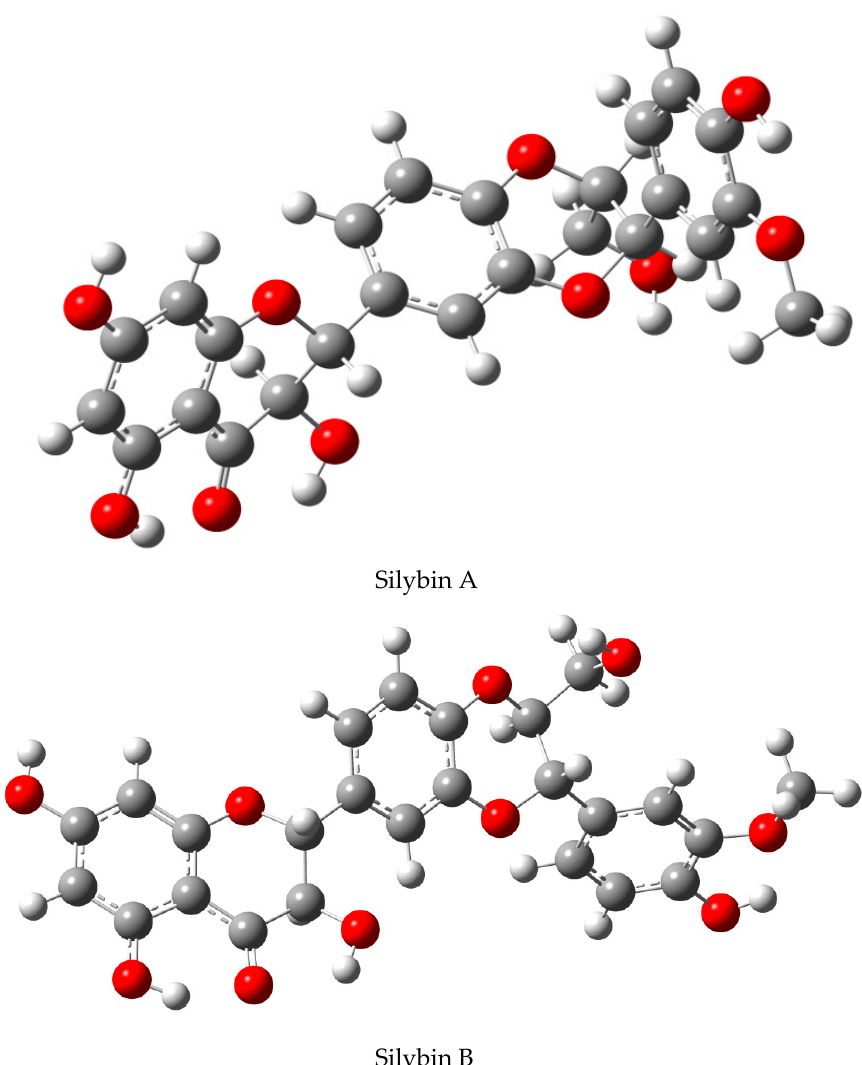
Figure 4. Molecular models of silybin A and silybin B; color code: red—oxygen; grey—carbon; white—hydrogen. Energy minimized structures prepared in program Gaussview https://gaussian.com/gaussview6/ (accessed 20 January, 2021).